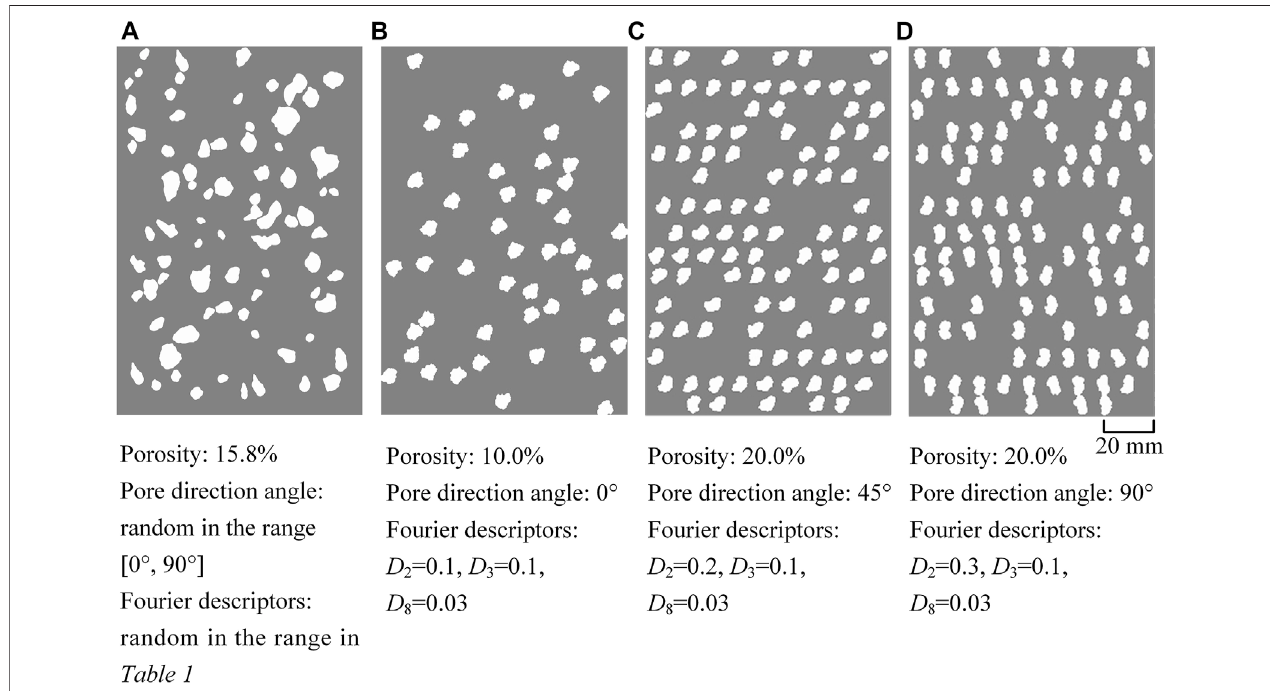
FIGURE6| Examplesofgeneratedporousrocksampleswithparametersporosityof (A,B) 15.8%; (C,D) 20.0%;poredirectionangleof (A) randomintherangeof [0 ° , 90 ° ]; (B) 0 ° ; (C) 45 ° ; (D) 90 ° ; Fourier descriptors D 2 , D 3 , and D 8 of (A) random in the range in Table 1 ; (B – D) 0.1, 0.1, and 0.03, respectively.